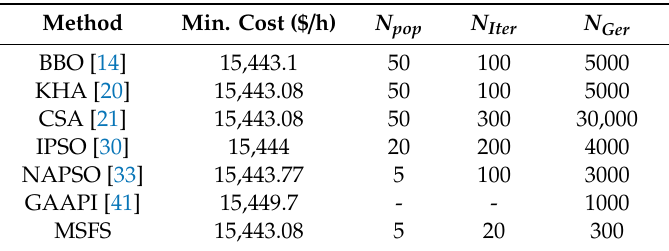
Table 8. Comparison of the implemented results for case 6.